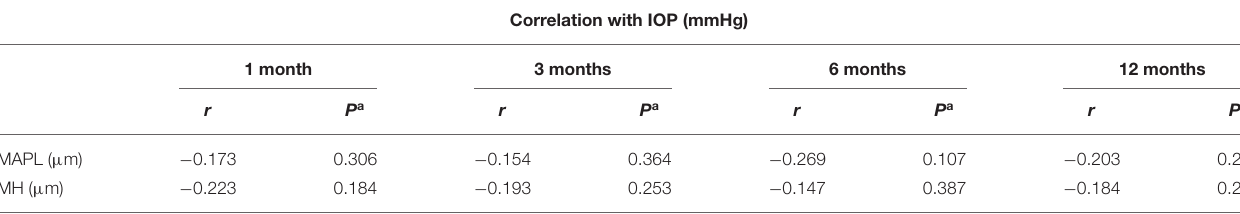
TABLE 7 | Correlations between MAPL, MH, and IOP after surgery.